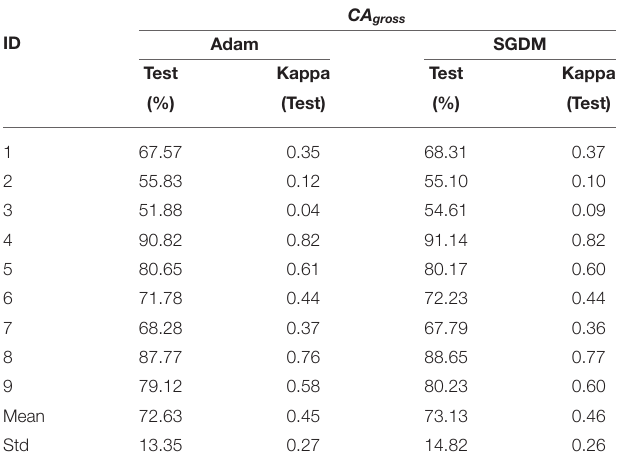
TABLE 5 | Performance of inter-subject learning for continuous decoding.